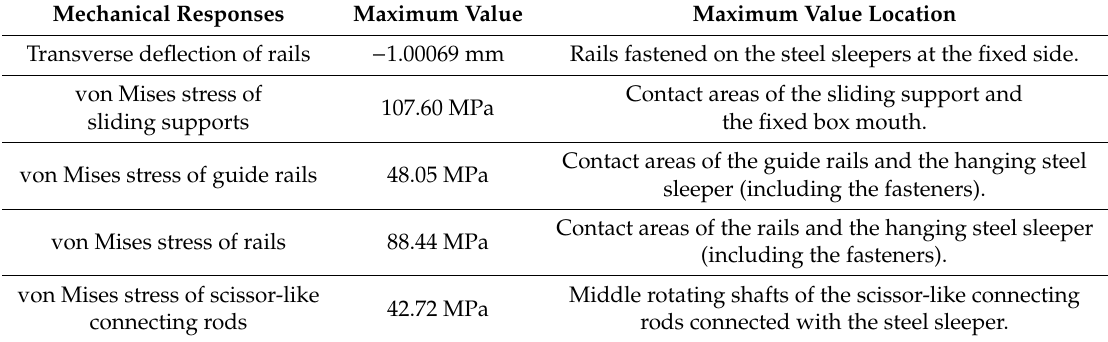
Table 2. Device mechanical responses under − 1 mm of transverse displacement on the fixed